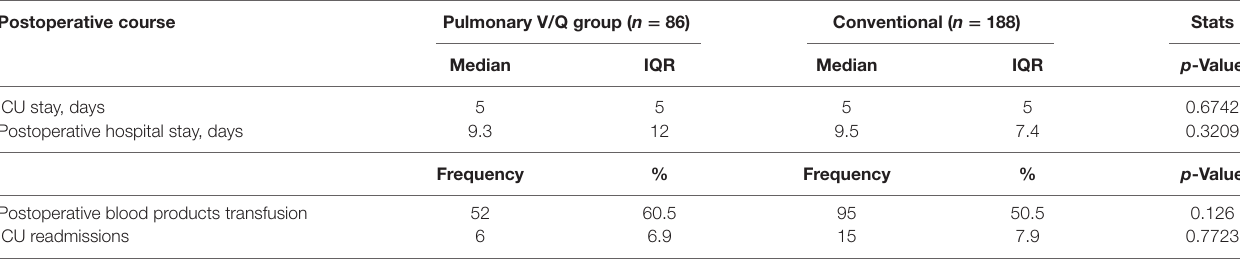
TaBle 3 | Postoperative course.